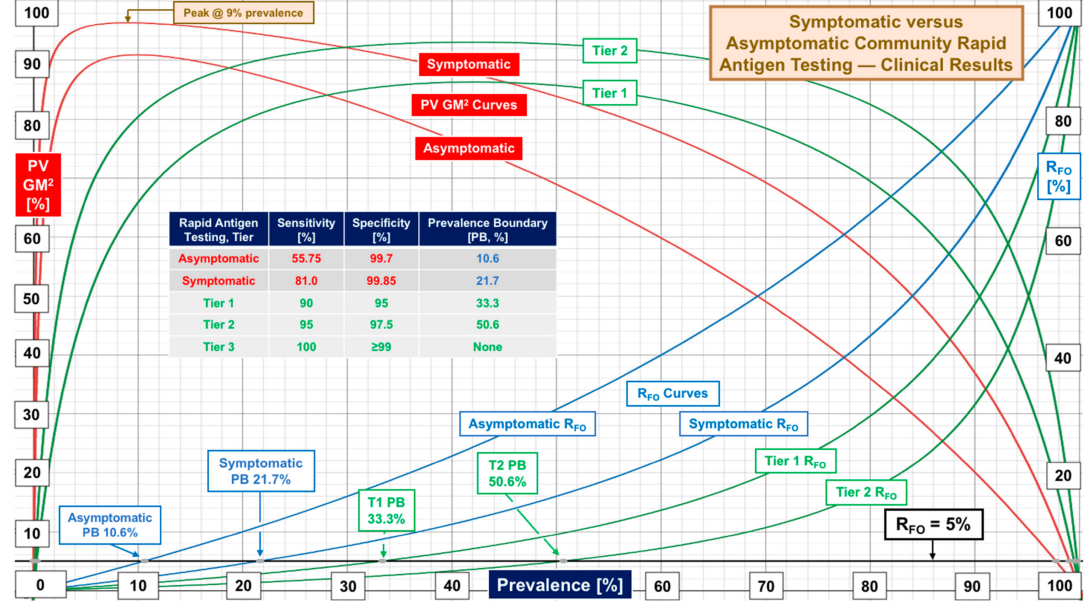
Figure 2. Comparison of symptomatic versus asymptomatic community rapid antigen testing performance based on